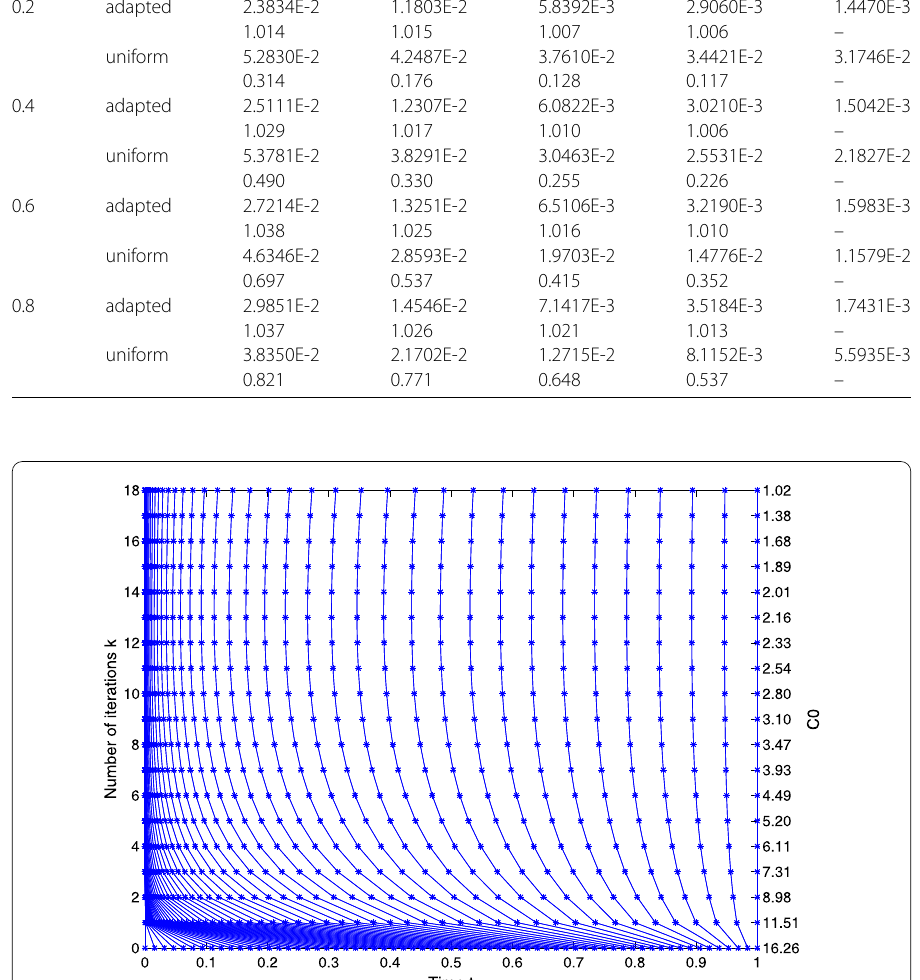
Figure 3 Evolution of the time mesh for Example 5.2 with α = 0.2